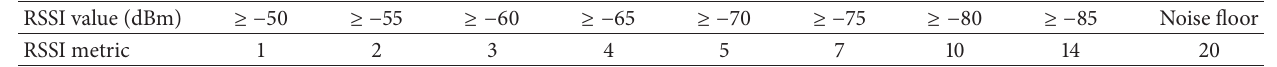
Table 1: Mapping node-to-end RSSI value to the